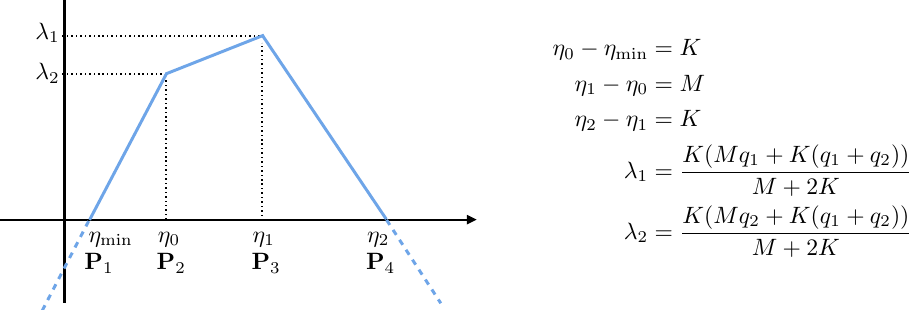
] is obtained by prolonging the outer- min , η 2 , . . . , P refer to figure 1. 1 4